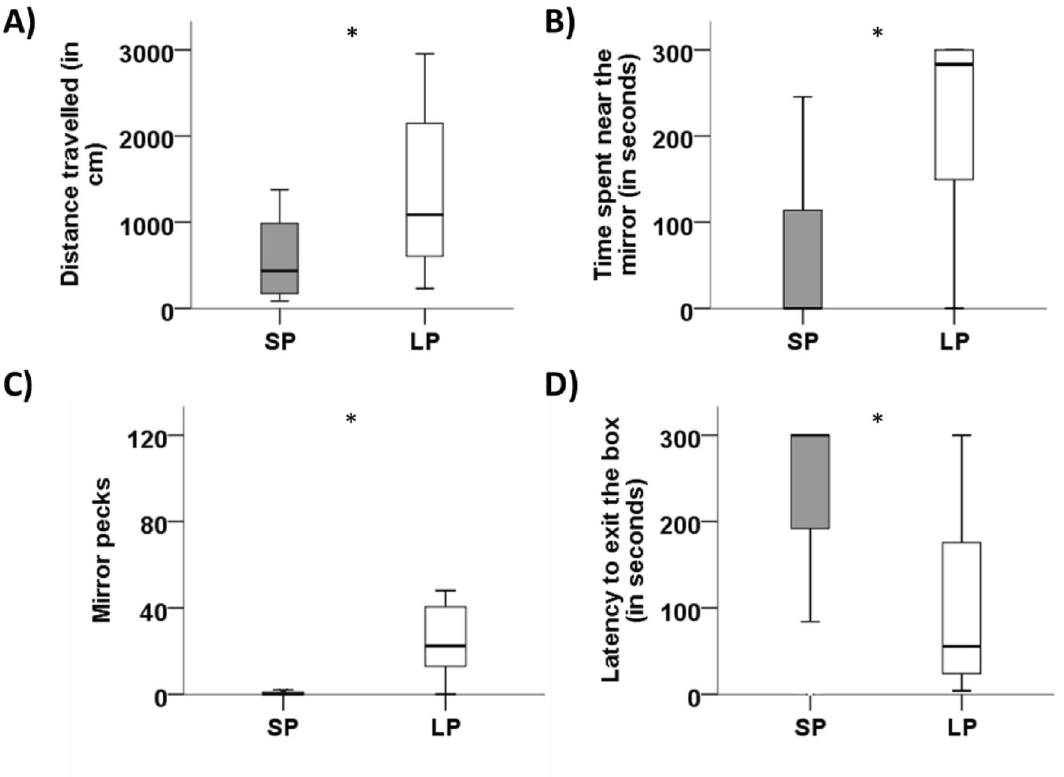
Figure 5. Effect of photoperiod on quail behavior. ( A ) Median distance travelled within the open field arena for quail exposed to short (SP) and long (LP) photoperiod. ( B ) Median time spent near the mirror (in seconds), during the mirror test, for SP and LP birds. ( C ) Median mirror pecks, during the mirror test, for SP and LP birds. ( D ) Latency to exit the black box compartment (in seconds), during the emergence test, for SP and LP birds. * p < 0.05. Data are presented as the 25th percentile, the median (the 50th percentile), and the 75th